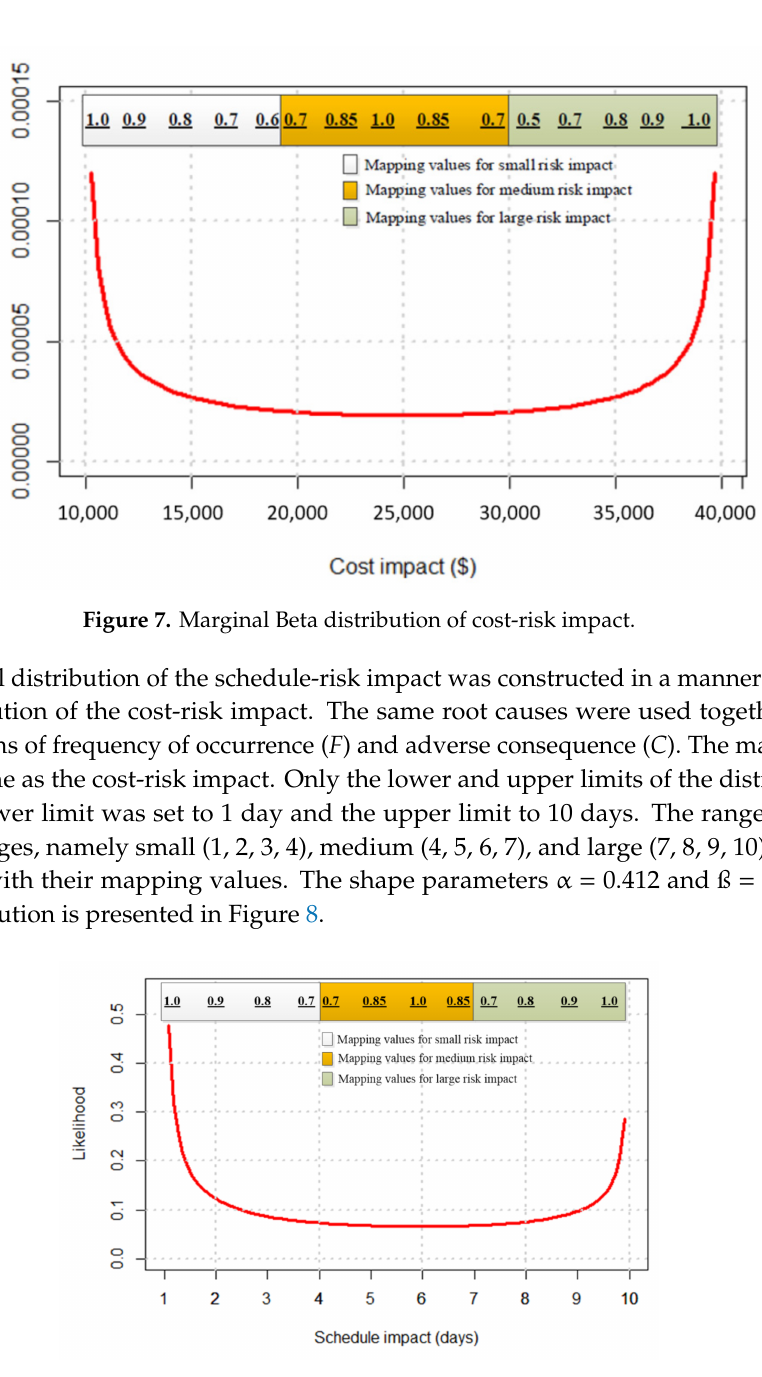
Figure 8. Marginal Beta distribution of schedule-risk